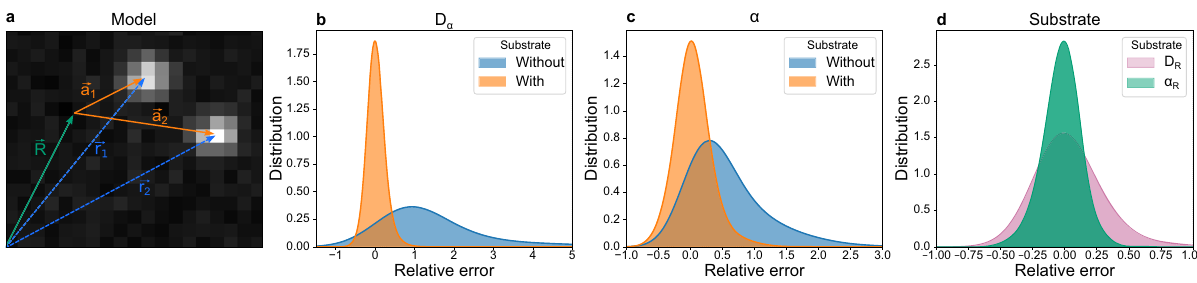
Fig. 2 GP-FBM can correct for substrate movement to improve estimation of diffusion parameters. ( a ) Scheme showing the measured trajectories of particles r 1 and r 2 as the combination of substrate motion R and particles' diffusion with respect to the substrate, a 1 and a 2 . ( b , c ) Distributions of relative errors for the estimation of diffusion parameters on 2000 pairs of simulated trajectories with uniform random parameters (0.1 < D i < 1.1, 0.3 < α < 1, 0.1 < D R < 1.1 and 0.7 < α R < 1.7; dt = 0.5, σ = 0.1 and o = 0.1) when substrate movement is accounted for (orange) or not (blue). (d) Distributions of relative errors for the estimation of diffusion parameters for the